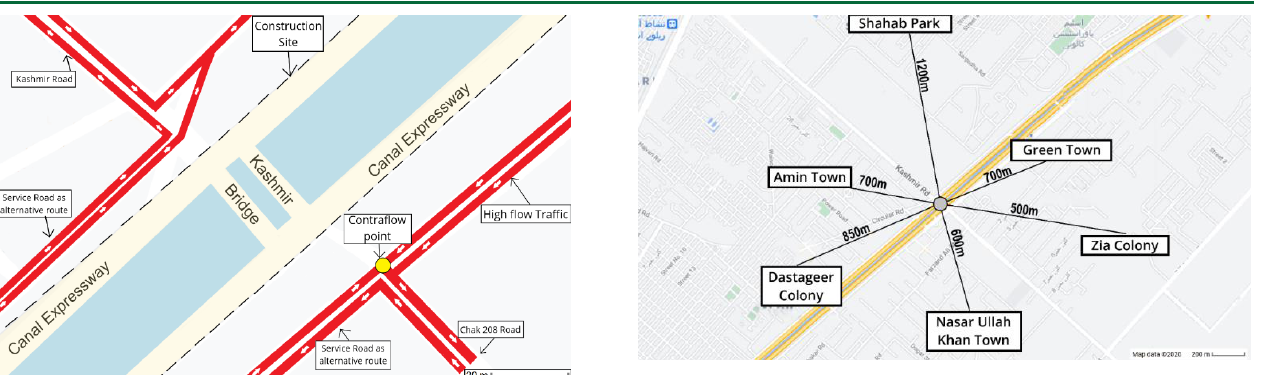
Figure 4: Distance between residencies under the impact radius and project